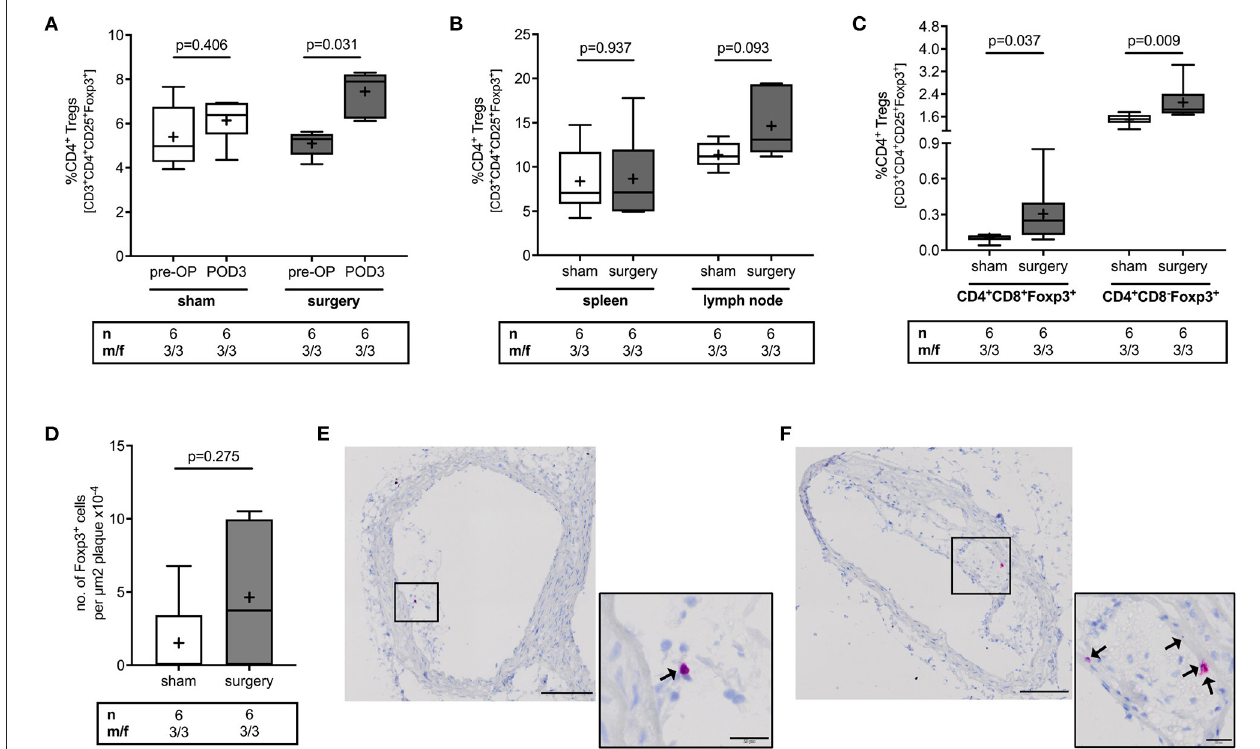
FIGURE 1 | Effect of perioperative stress on regulatory T cell count in blood, spleen, lymph node, thymus and atherosclerotic plaques of ApoE − / − mice. ApoE − / − mice of mixed gender were fed a Western diet for 9 weeks and were exposed to the surgical stress model or the sham intervention at the age of 17 weeks. Sham mice additionally received a 100 µ l blood draw at the day of surgery. (A) Blood count of Tregs was quantified preoperatively (pre-OP) and on postoperative day 3 (POD3), at the day of sacrifice using flow cytometry. Postoperatively, the number of Tregs was quantified in (B) spleen and lymph nodes, (C) tyhmus, and (D–F) in atherosclerotic plaques of the brachiocepahlic artery. Immunohistochemical images of atherosclerotic plaques showing a representative number of Tregs in mice that underwent (E) the sham intervention or (F) surgery. Scale bars represent 100 and 20 µ m of overview and close-up images, respectively. The total number of mice under study as well as the ratio of male to female mice is indicated per group. Statistical comparisons were performed using non-parametric Wilcoxon signed-rank or Mann-Whitney U test, as appropriate.